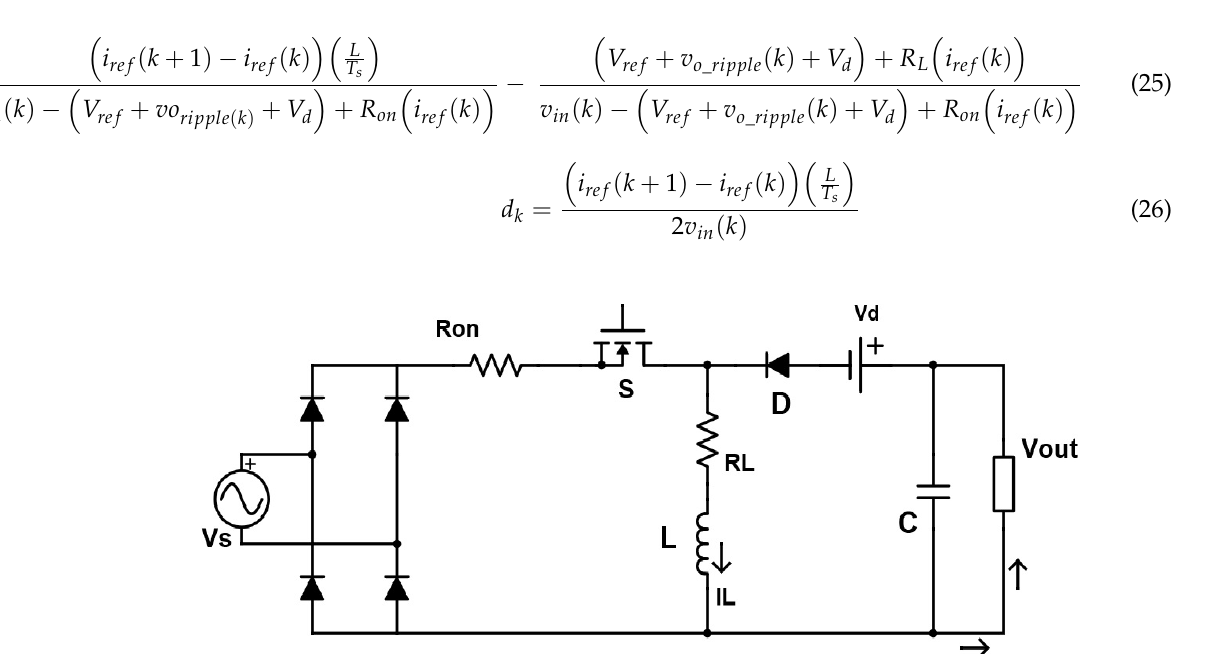
Figure 4. Detailed diagram of buck-boost converter. Equations (25) and (26) are the required feed-forward control for buck-boost PFC operating in CCM and DCM, respectively. Output voltage ripple v o_ripple and v in ( k ) can be calculated by: